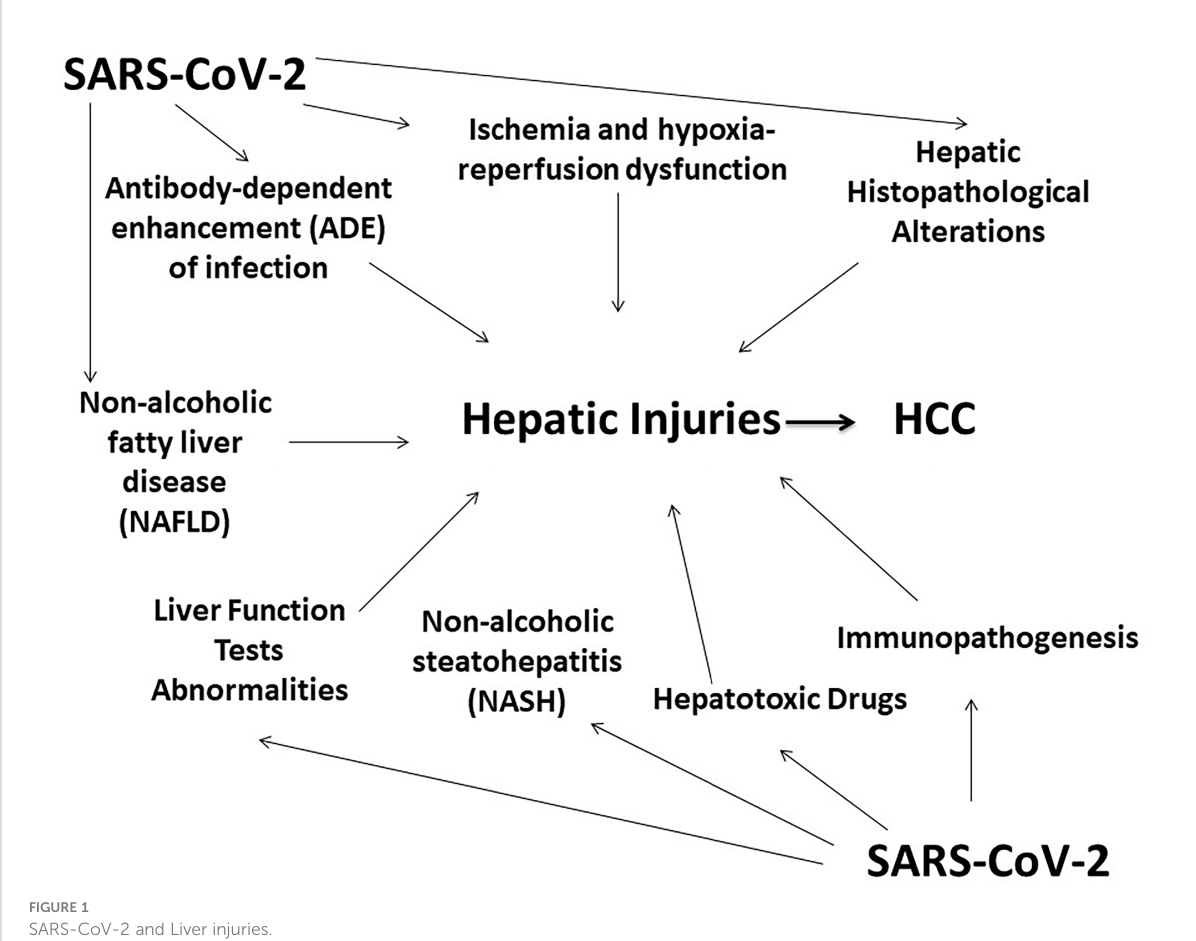
FIGURE 1 SARS-CoV-2 and Liver